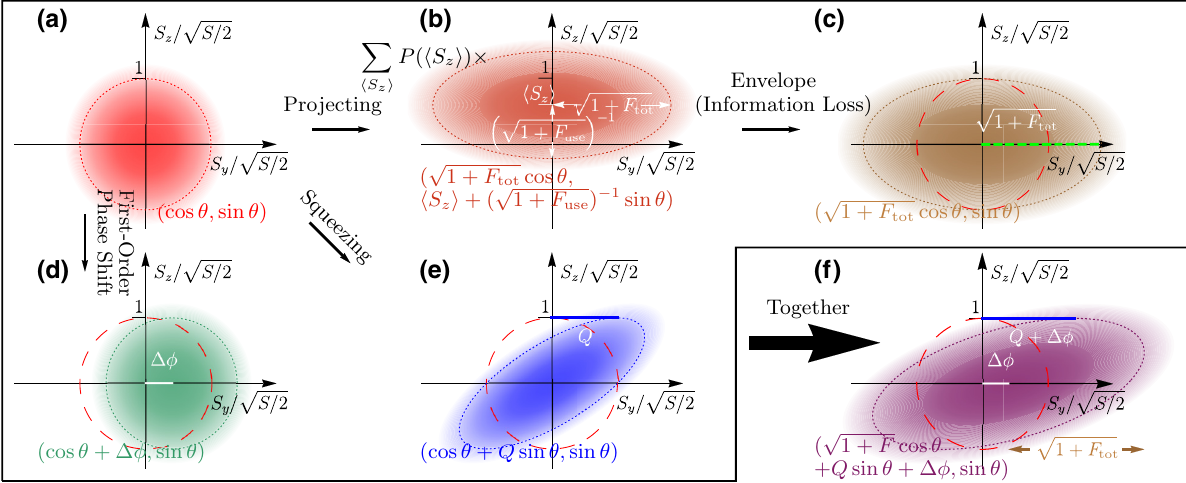
FIG. 4. Results of cavity feedback squeezing for a cavity that is resonant with the atomic transition, ω c = ω a . (a) Squeezing strength Q , quantum Fisher information F , and inverse Wineland parameter ξ − 2 at fixed scattered photon number n sc γ = 400 and collective cooperativity N ↑ η = 900. (These parameters correspond to the conditions of the experiment described in Ref. [27].) For the Q plot, red branches stand for positive Q and blue branches for negative Q . In this calculation, the curvature of the Bloch sphere has been ignored, and the results do not depend on the single-atom cooperativity η . (b) Inverse Wineland parameter including the effect of the Bloch sphere curvature for different scattered photon numbers n sc γ calculated for the parameters N = 1000, (cid:6) S z (cid:4) = 0, and η = 1.8. In both (a) and (b) we assume that κ/(cid:13) = 2.8, as in the experiments of Refs.